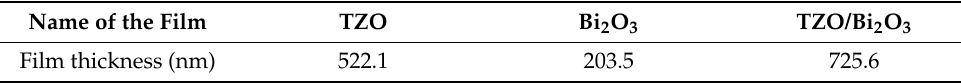
Table 2. The thickness of each layer of TZO/Bi 2 O 3 heterojunction